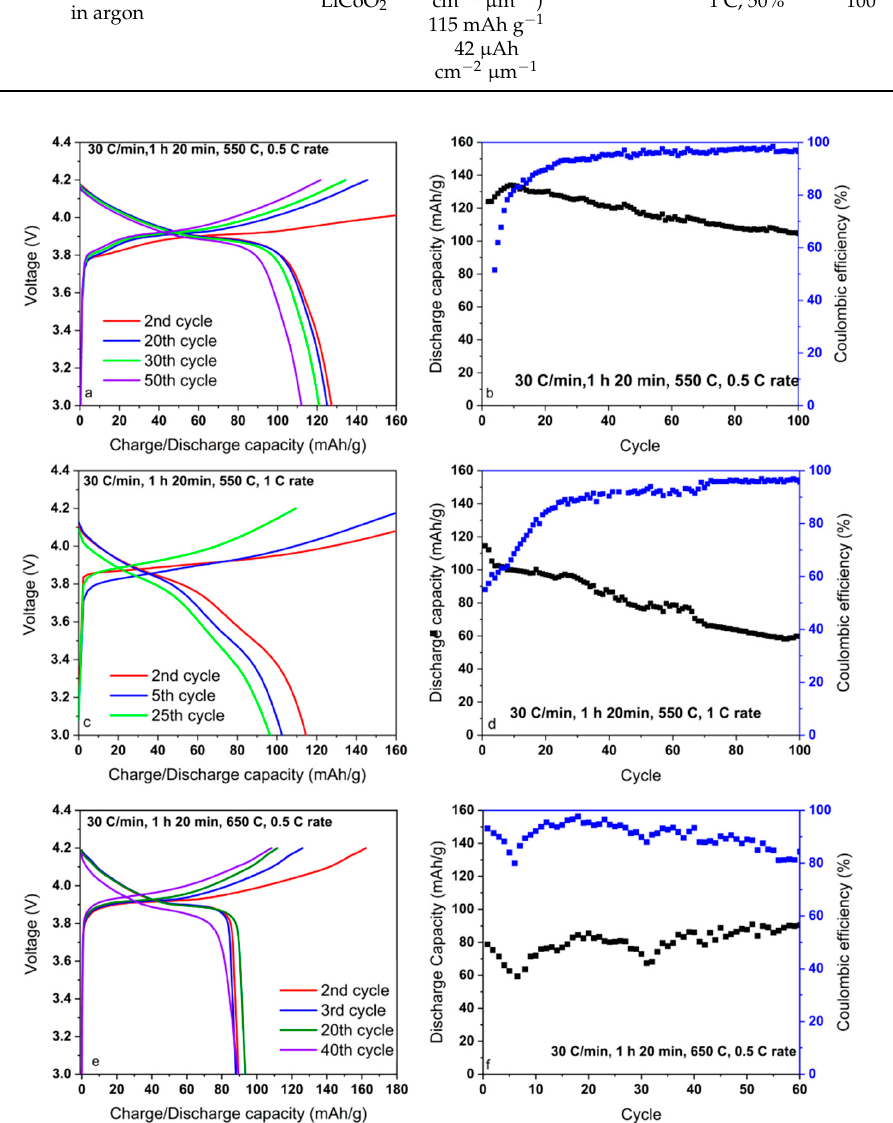
Figure 7. Potential profiles and cycling performances of LiCoO 2 , respectively: ( a , b ) 1 h 20 min annealed with ramp rate of 30 ◦ C min − 1 at 550 ◦ C with 2 initial cycles by 0.1 C, hereafter 0.5 C; ( c , d ) 1 h 20 min with ramp rate of 30 ◦ C min − 1 at 550 ◦ C at 1 C; ( e , f ) 1 h 20 min for 650 C at 0.5 C.